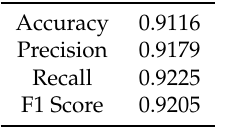
Table 6. Classification